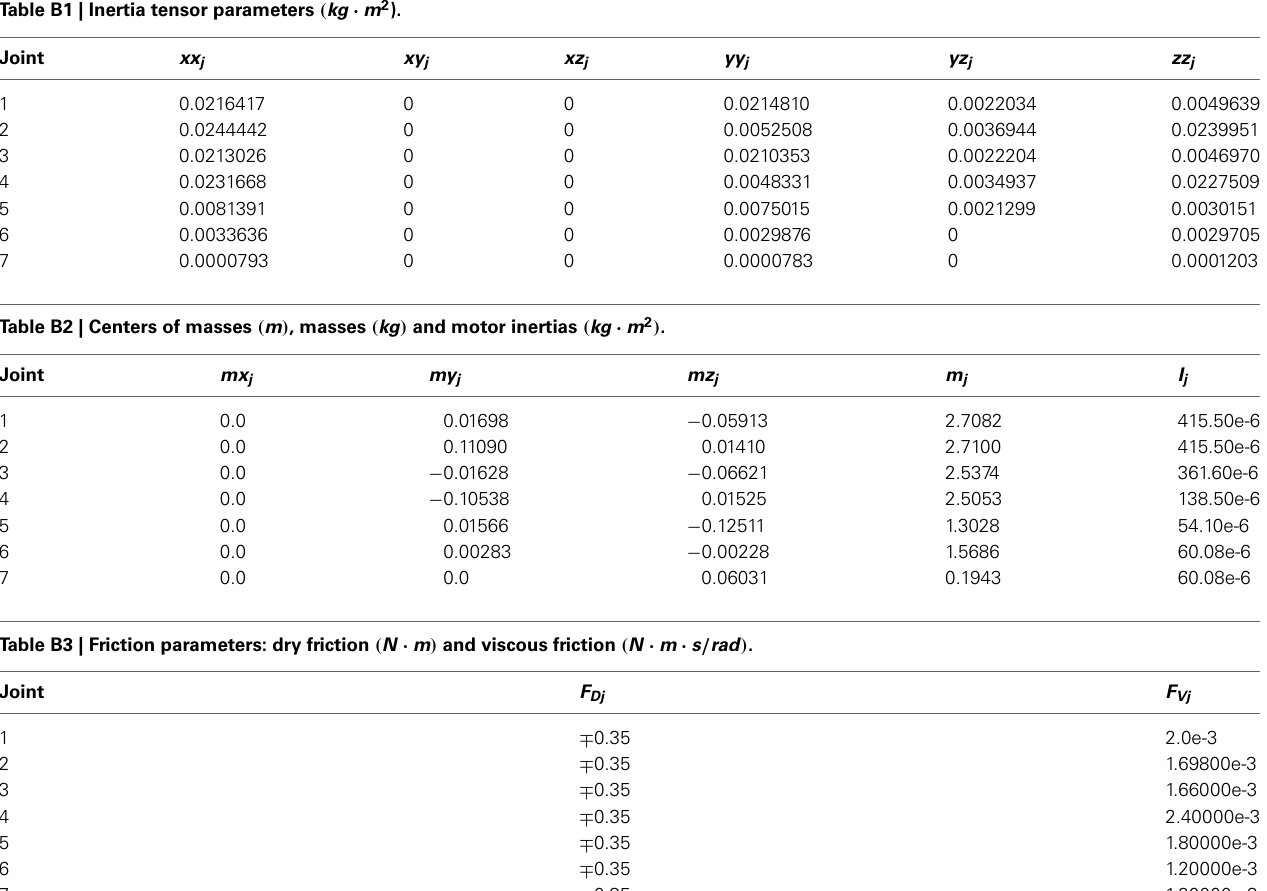
Table B1 | Inertia tensor parameters ( kg · m 2 ).